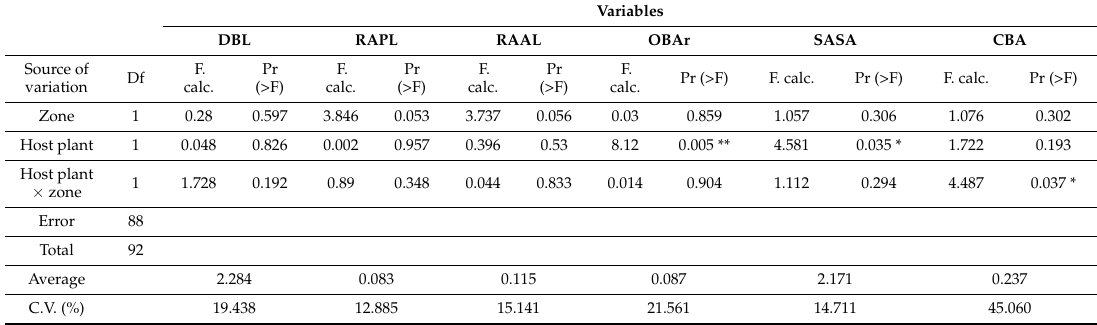
Table 4. ANOVA test for the descriptive variables of the female genitalia of N. elegantalis collected in two hosts ( S. quitoense and tree S. betaceum ) and two zones (Western Andes and Eastern Andes). Variables